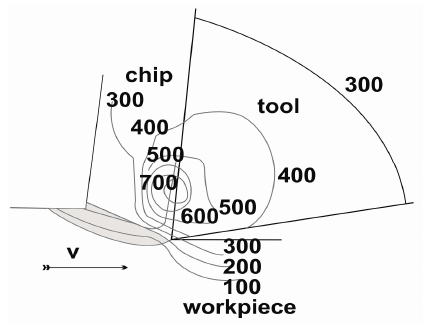
Figure 2. Co-temperature curves [24].